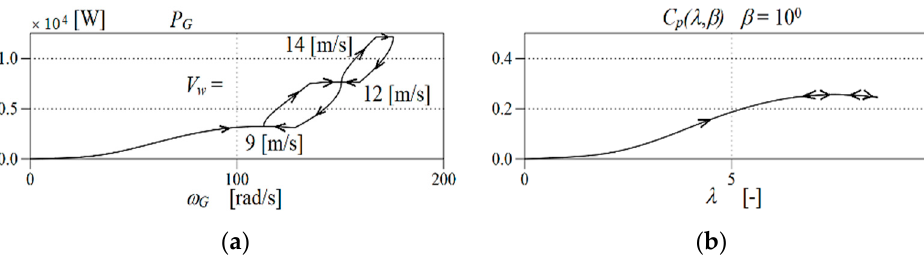
Figure 14. The waveforms of the angle of the wind turbine blades β , the angular velocity ω G , the power P G and supplied to the power grid P S .